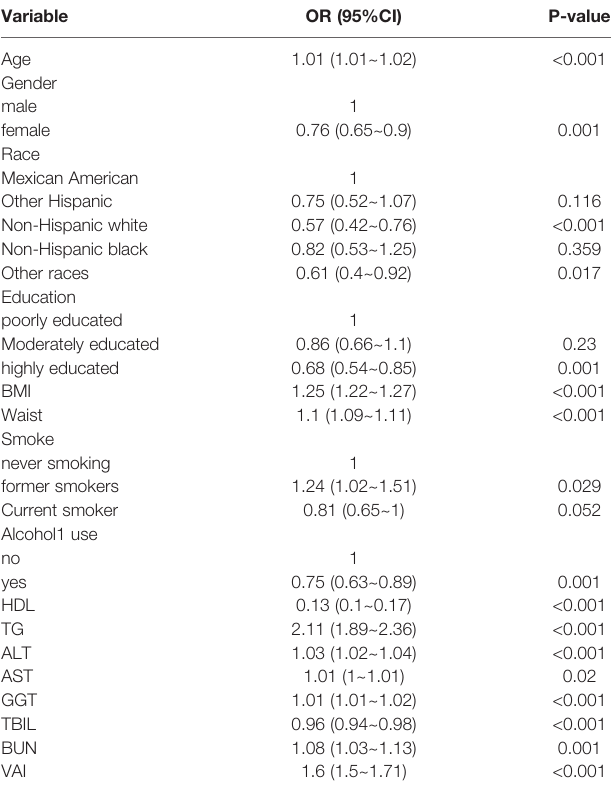
TABLE 2 | Univariate analysis for IR.